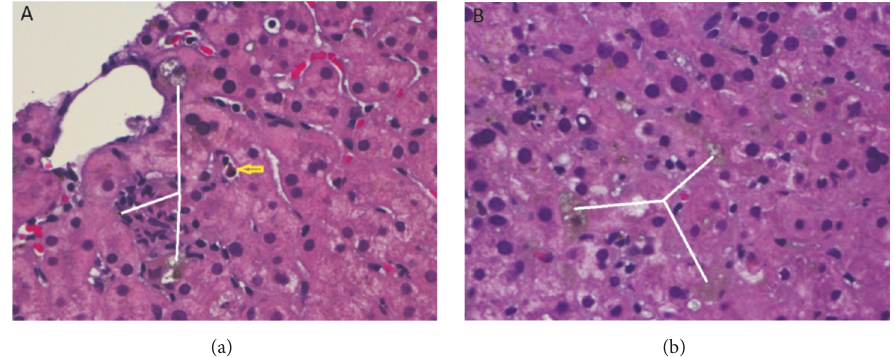
Figure 1: Liver core biopsy demonstrated (a) cholestasis and inflammatory infiltrates and (b) moderate canalicular cholestasis. The white lines indicate cholestasis and bile plugging. The yellow arrow indicates an eosinophil. H&E stain high power (400x) highlighted these findings.